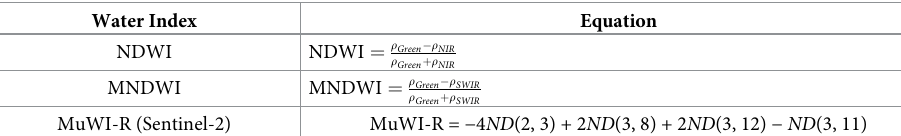
Table 3. Expression of NDWI, MNDWI and